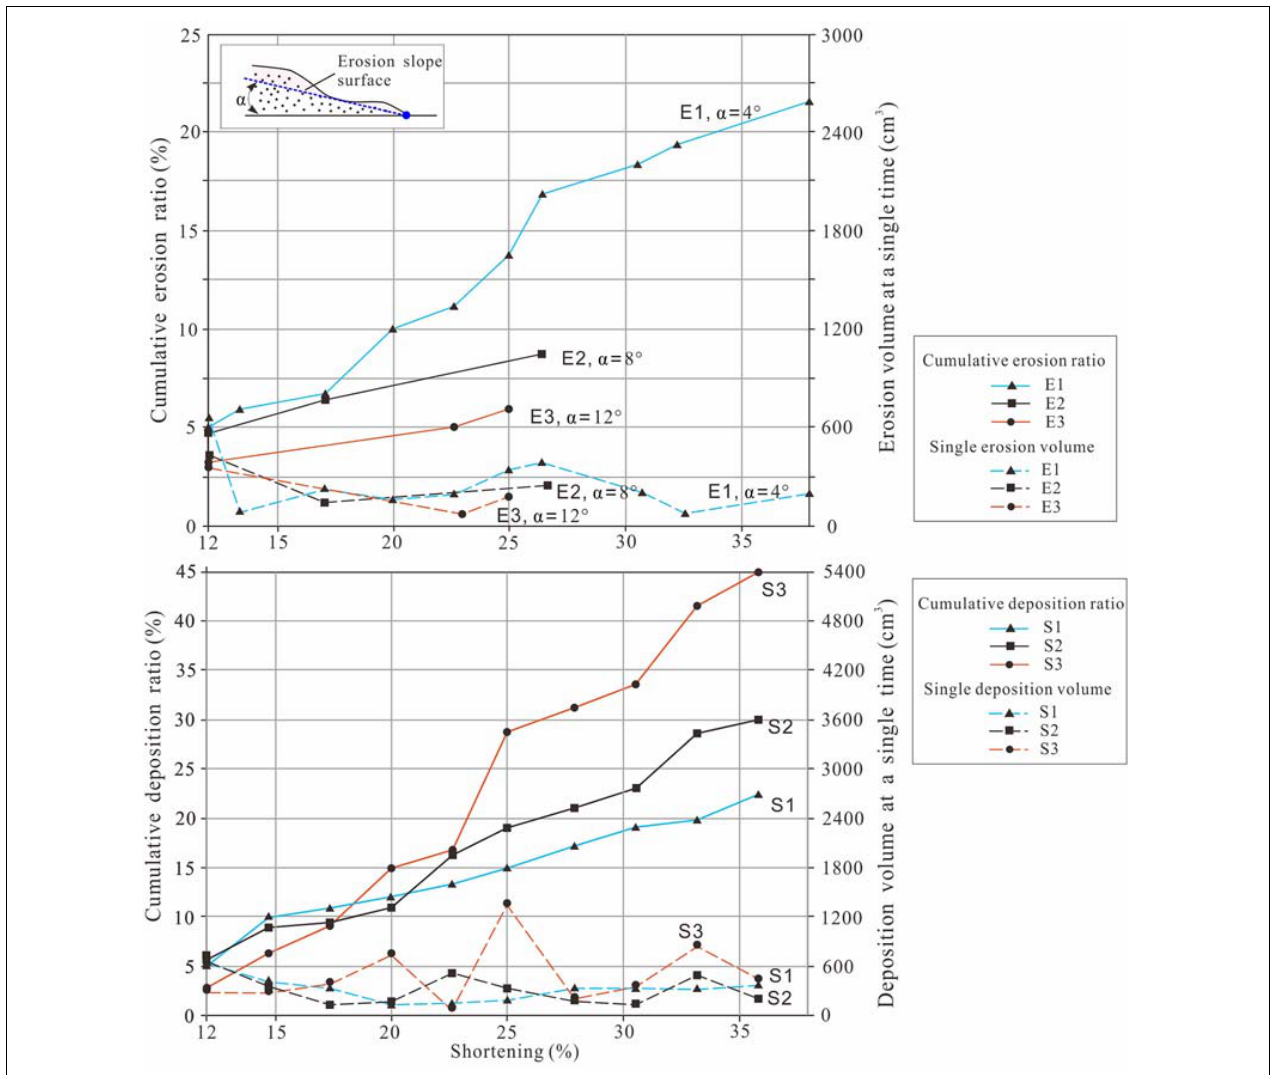
FIGURE 10 | Volume of erosion and sedimentation versus shortening. The cumulative erosion ratio is the ratio of cumulative erosion volume to original volume of quartz sand in the model; the cumulative deposition ratio is the ratio of cumulative sedimentation volume to original volume of quartz sand in the